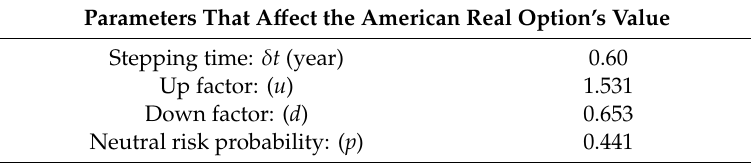
Table 12. Recombining binomial lattice parameters (Natura’s acquisition of Avon Products Inc).